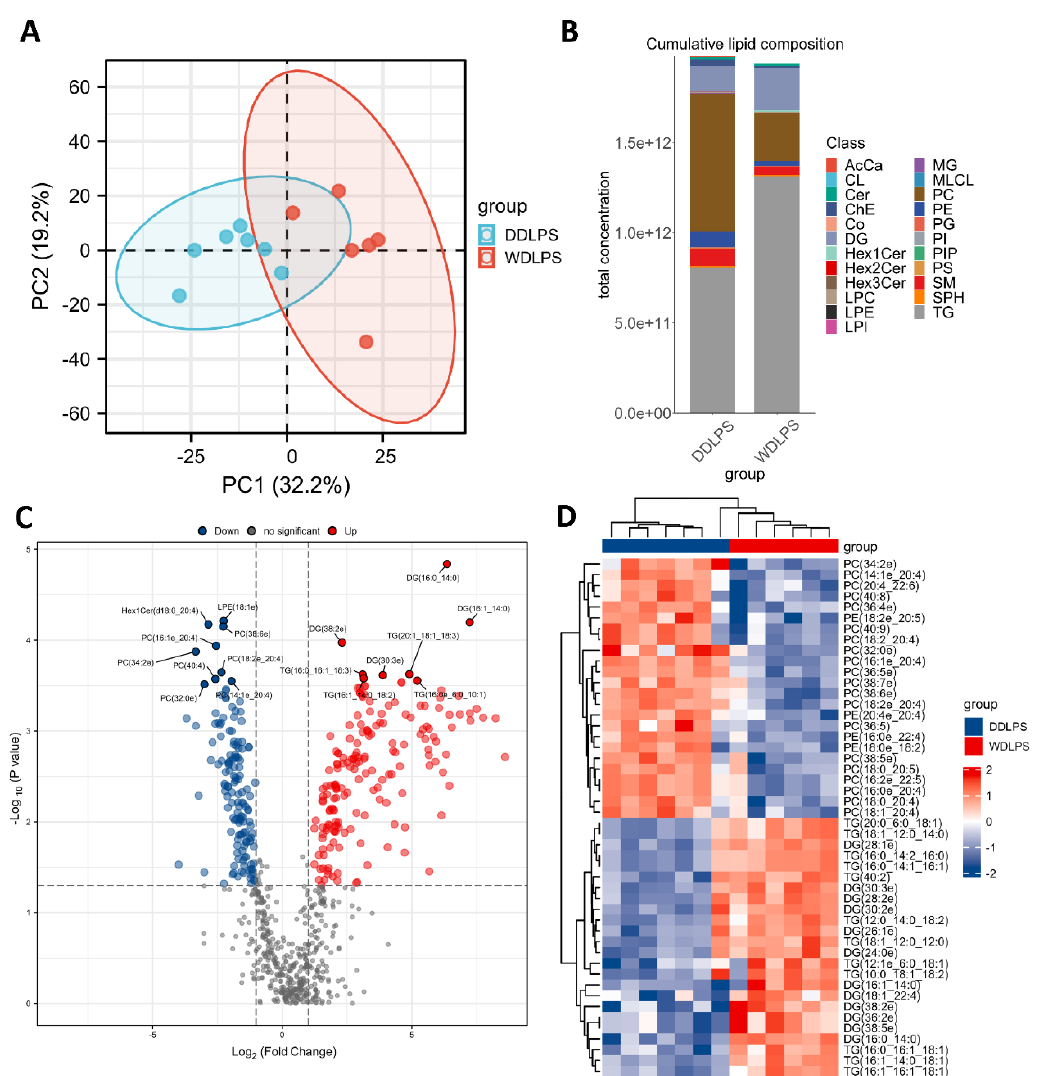
Figure 1. Lipid profiles of WDLPS and DDLPS tumors. ( A ) The PCA score plot of the two sub- types of tumors. Each blue dot in (A) represents a DDLPS tumor, and each red dot represents a WDLPS tumor. ( B ) The stacked histogram of cumulative lipid classes in the two subtypes of tumors. ( C ) The volcano plot showing the significantly changed lipids in WDLPS compared to DDLPS. (D) The heatmap showing the top 48 altered lipids in WDLPS and